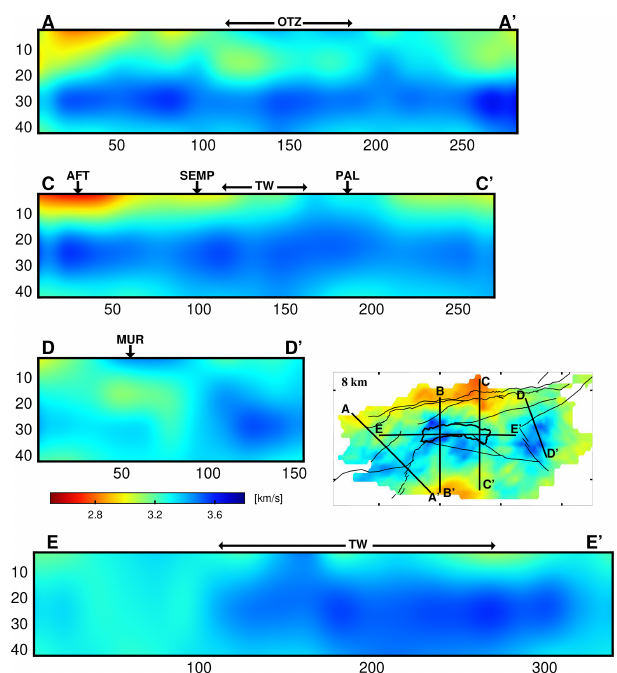
Figure 14. Cross sections of the Rayleigh-wave shear velocity model. Surface locations of the Ötztal block (OTZ), Tauern Win- dow (TW), Periadriatic fault (PAL), Salzach–Ennstal–Mariazell– Puchberg (SEMP), northern Alpine Front Thrust (AFT), and Mur– Mürz fault (MUR) are shown on the profiles. Profile locations are presented in the 8km depth slice. The Tauern Window (TW) and the main faults are shown by black lines (see Fig. 1 for fault names).